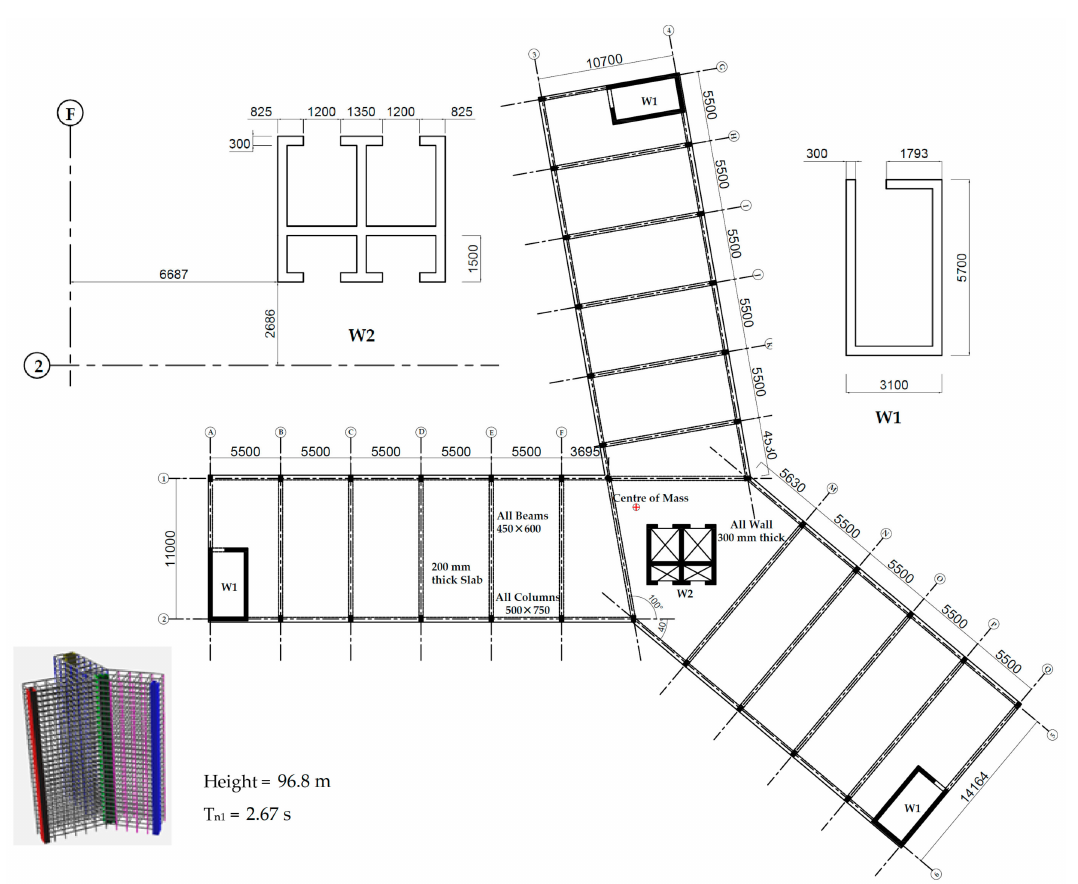
Figure 13. Floor plan, structural layout, and elevation view of CSB 3 (all dimensions are in